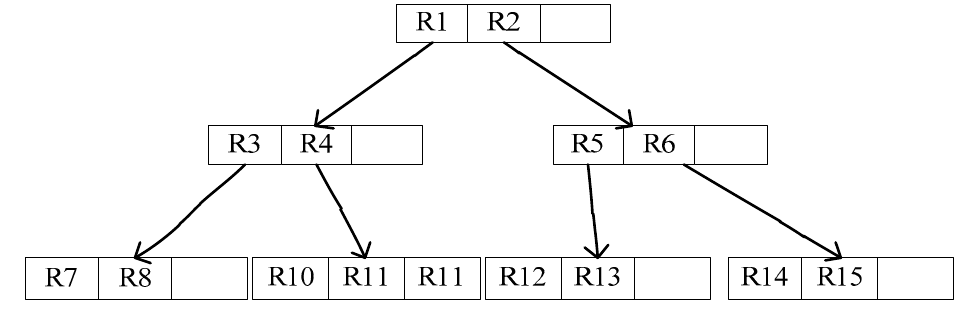
Figure 3. R-tree data structure.